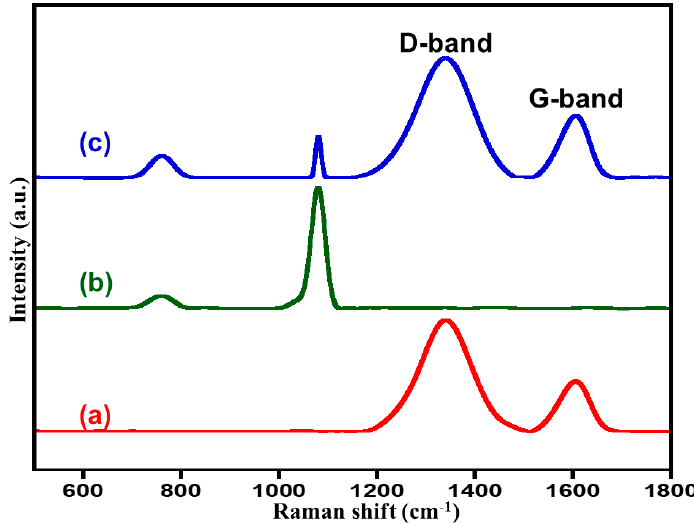
Figure 5. Raman spectra for ( a ) GO; ( b ) ZnO x (1%)–MnCO 3 ; and ( c ) ZnO x (1%)–MnCO 3 /(1%)HRG.